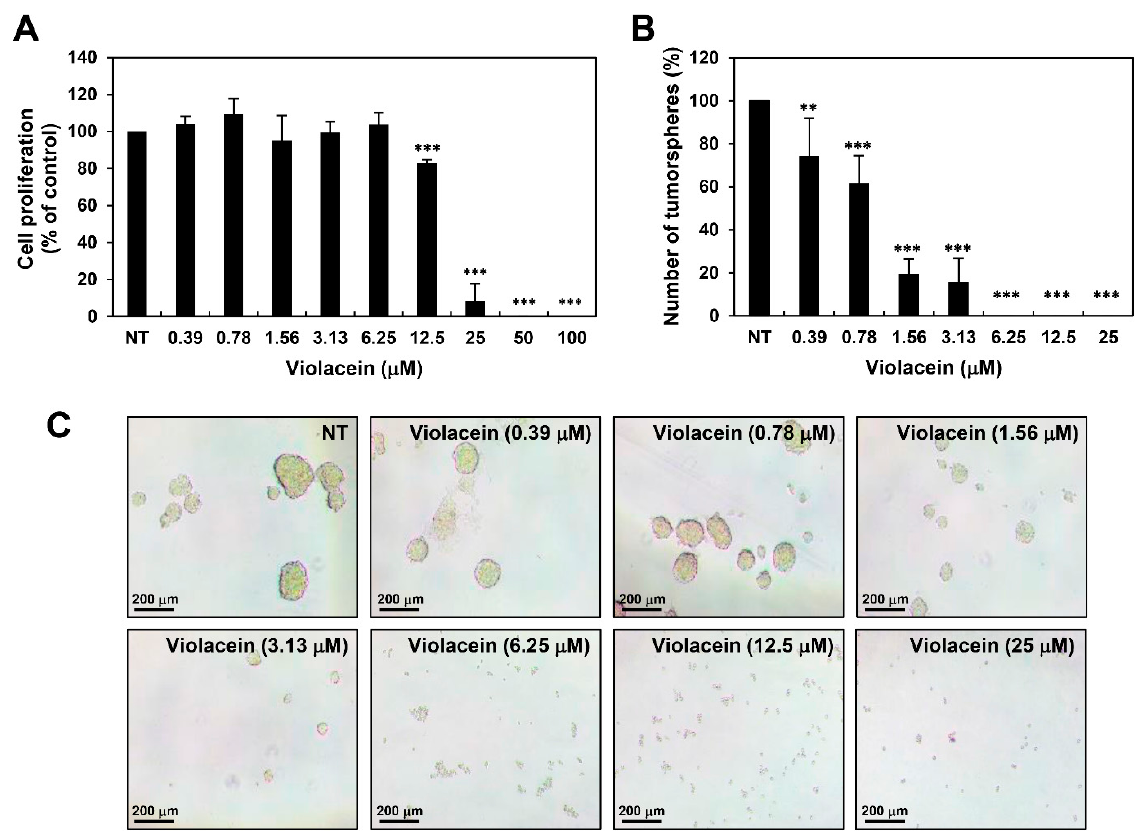
Figure 5. Violacein inhibits the proliferation and formation of tumorspheres of Huh7 cancer stem-like cells. ( A ) Effect of violacein on the proliferation of Huh7 cancer stem-like cells. The cells were treated with violacein at various concentrations (0 − 100 µM) and were incubated with the CSC culture media for 7 days. Cell proliferation was measured using the CellTiter-Glo ® luminescent assay system. ( B,C ) Effect of violacein on the tumorsphere-forming ability of Huh7 cancer stem-like cells. The cells were treated with violacein at various concentrations (0 − 25 µM) and were incubated with the CSC culture media for 7 days. The number of tumorspheres in each well was counted under an optical microscope. ∗∗ p < 0.01, ∗∗∗ p < 0.001 vs. the control.